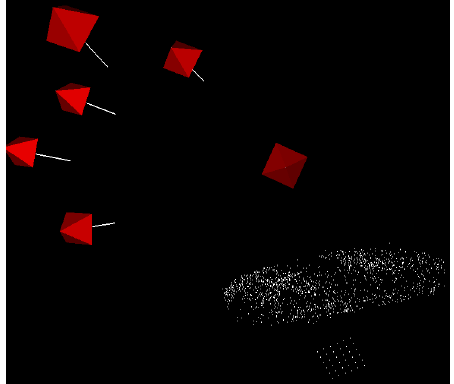
Figure 2. The camera positions of the six selected frames are shown along with the reconstructed model of a sample object. Algorithm 1 Choosing six frames to obtain a good coverage of the object function ON S ENSOR C HANGED (SensorEvent